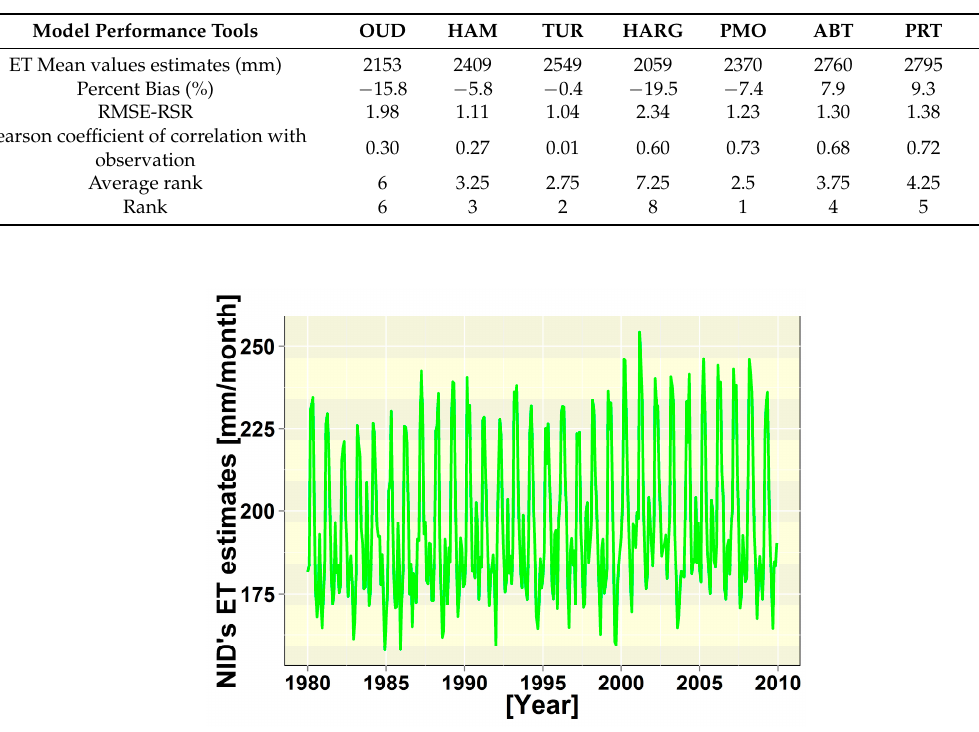
Figure 5. Monthly Potential Evapotranspiration (PET) computed using the Penman-Monteith model for the period of 1980 to 2010 in the NID.